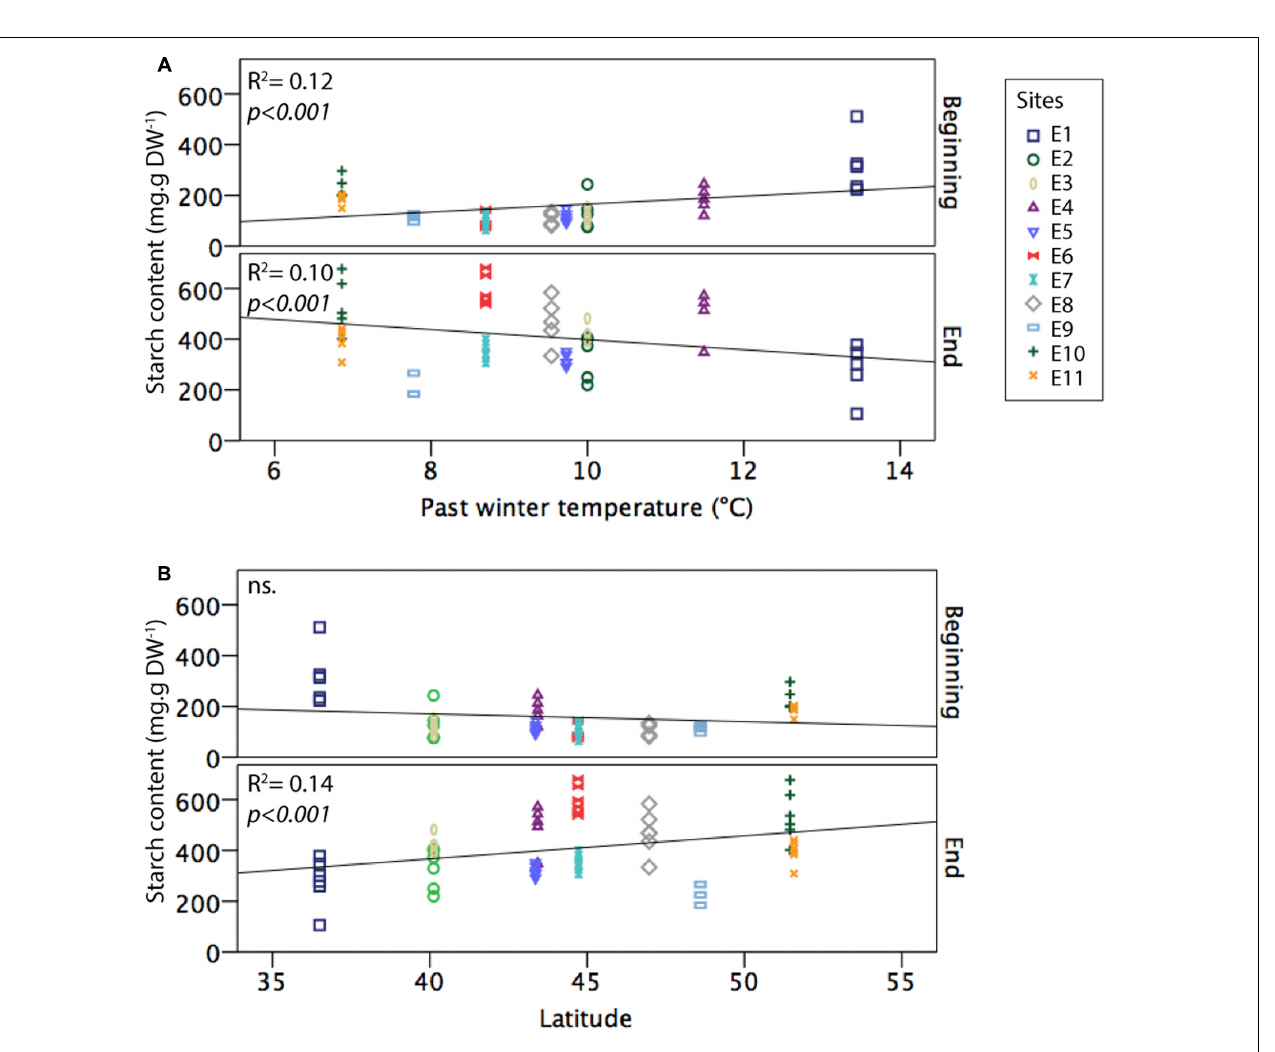
Frontiers in Plant Science |